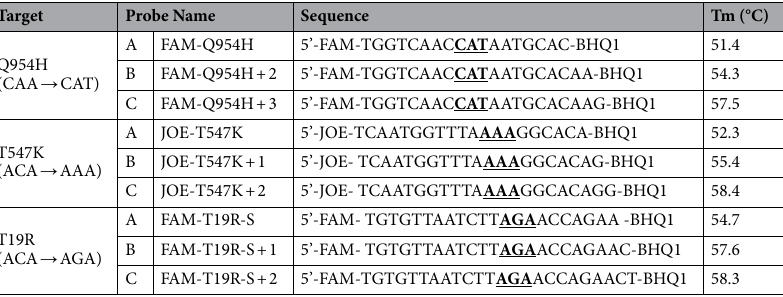
Table 1. Probe sequence and Tm information used for